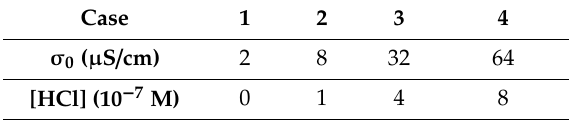
Table 1. Aqueous solution initial conductivities ( σ 0 ) and the corresponding HCl concentrations.